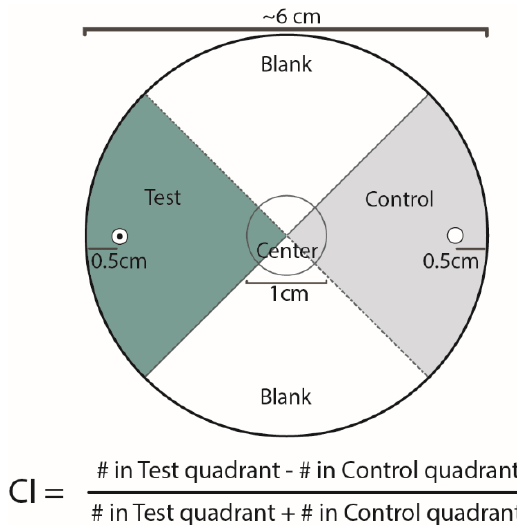
Figure 1. Scoring template for the PF127 gel assay. Assays were done using 60 mm petri dishes filled with approximately 10 mL of prepared PF127. Five microliters of the test compound (prenol) was placed within the test region at the designated position, while 5 µL of the control (diluent) was placed within the control region at the designated position. Approximately 100 infective juveniles (IJs) (which had been stored at 15 °C prior to the assays) were placed just under the surface of the media (at the center) before it solidified at room temperature, leaving the IJs embedded in the PF127 3-dimensional matrix during the assay, unless they moved to the surface on their own. Assays were run at room temperature, approximately 23 °C before being scored. Chemotaxis index (CI) is calculated as shown.